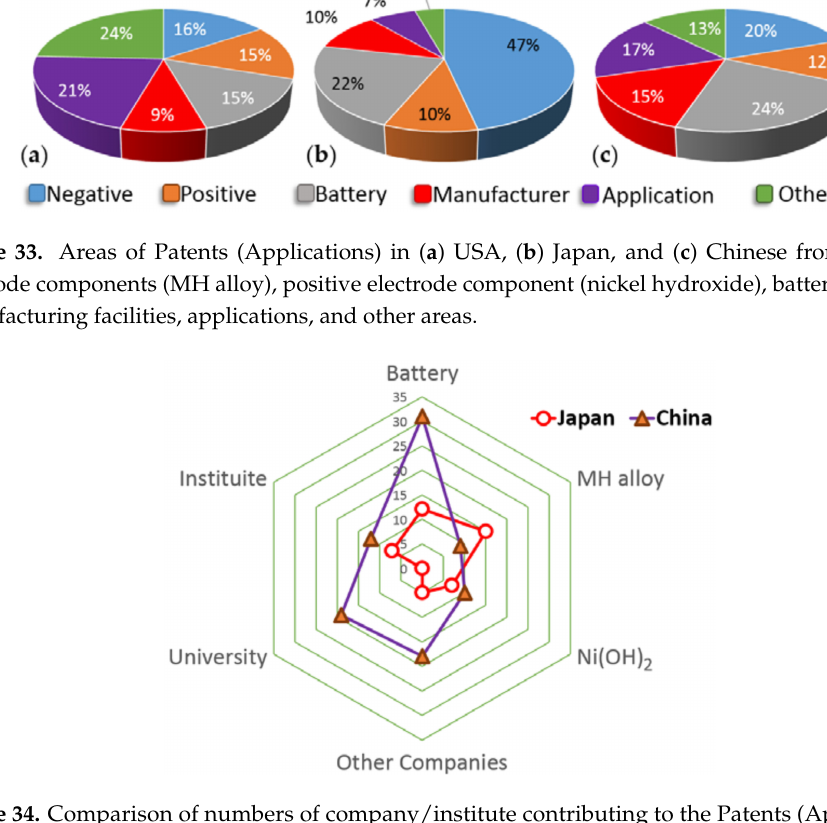
Figure 34. Comparison of numbers of company/institute contributing to the Patents (Applications) in Japan and